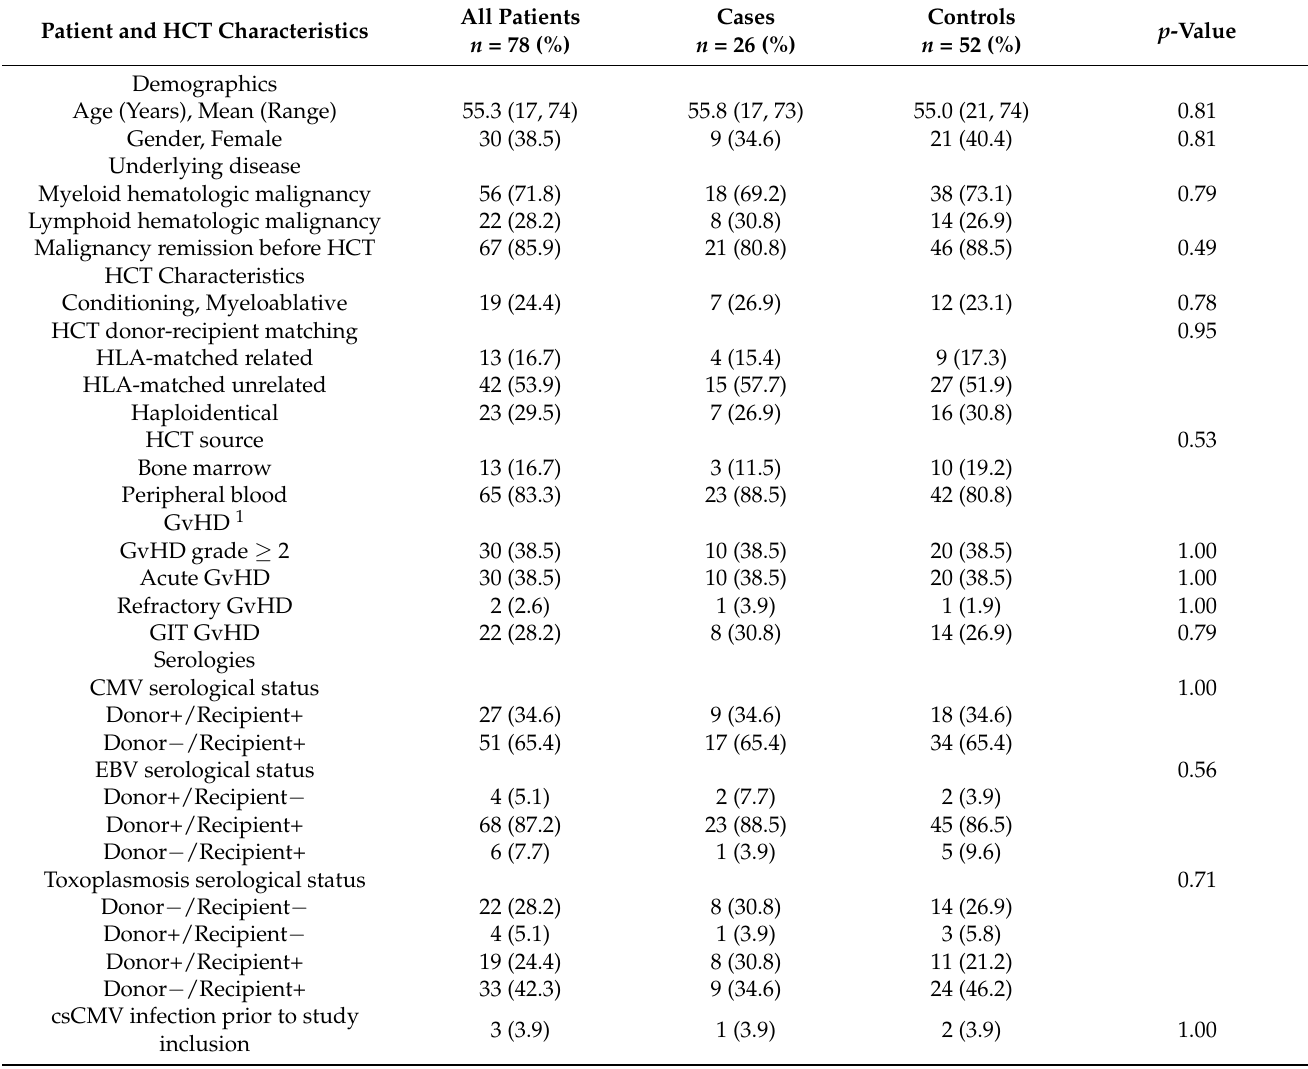
Table 1. Baseline patient